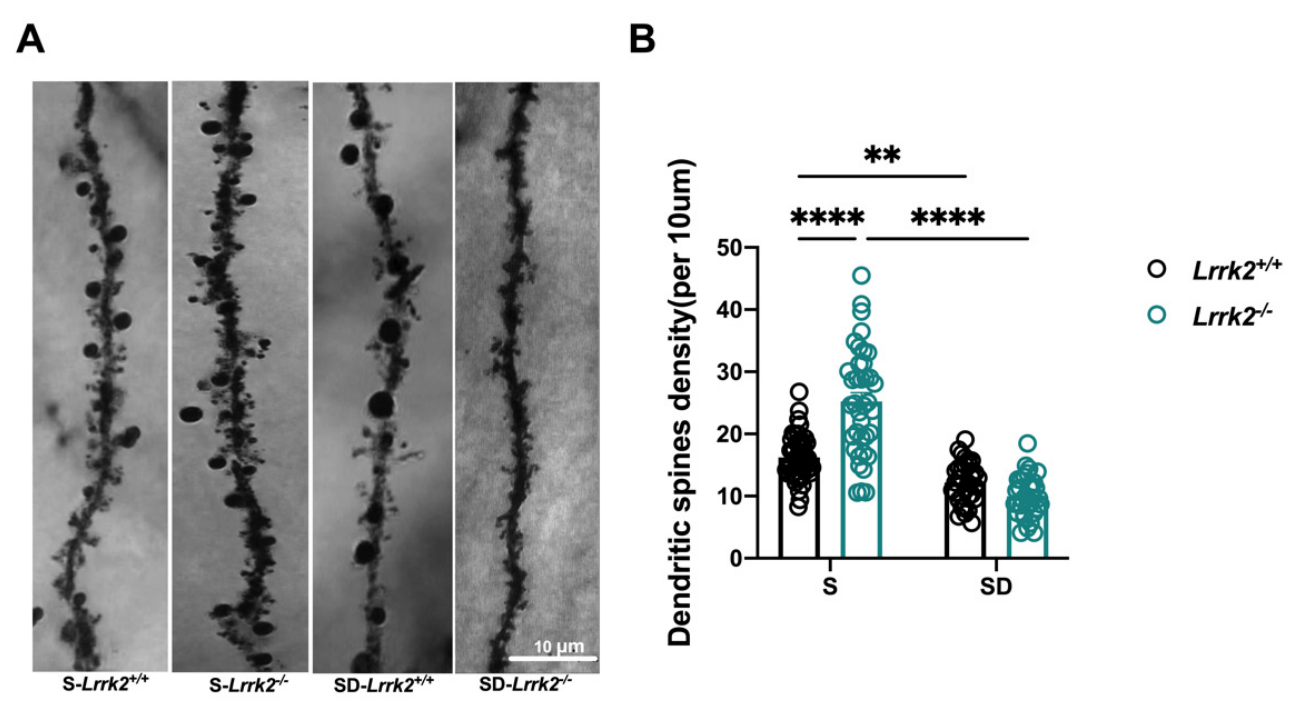
Figure 2. The LRRK2 deficiency-induced decease in dendritic spinal density after SD. ( A ) Representative images of secondary branches of apical dendrites by Golgi-staining, original magnification 100 × Oil; Scale bar = 10 μ m. ( B ) Relative quantification of dendritic spines in the PFC: N = 4 mice, n = 34~48 dendrites. Data are plotted as mean ± SEM. ** p < 0.01, **** p < 0.0001, by two-way ANOVA analysis with Tukey’s multiple comparisons test.